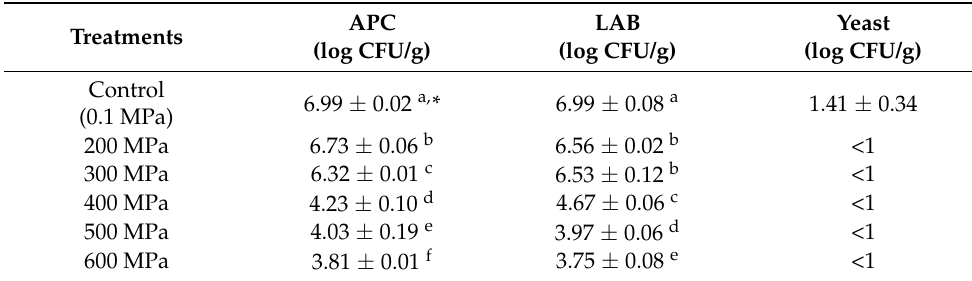
Table 1. Value of aerobic plate count (APC), lactic acid bacteria count (LAB), and yeast in